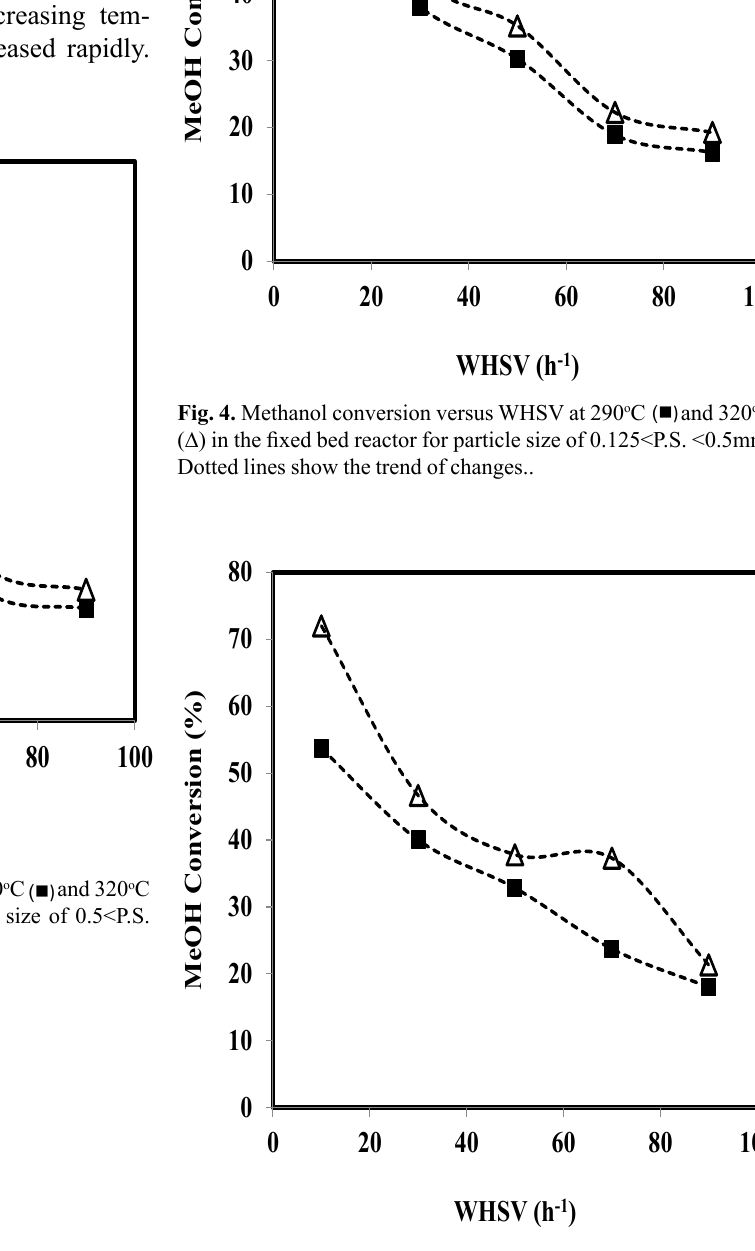
Fig. 5. Methanol conversion versus WHSV at 290 o C and 320 o C (∆) in the fixed bed reactor for catalyst particle size of 0.063<P.S. <0.125mm. Dotted lines show the trend of